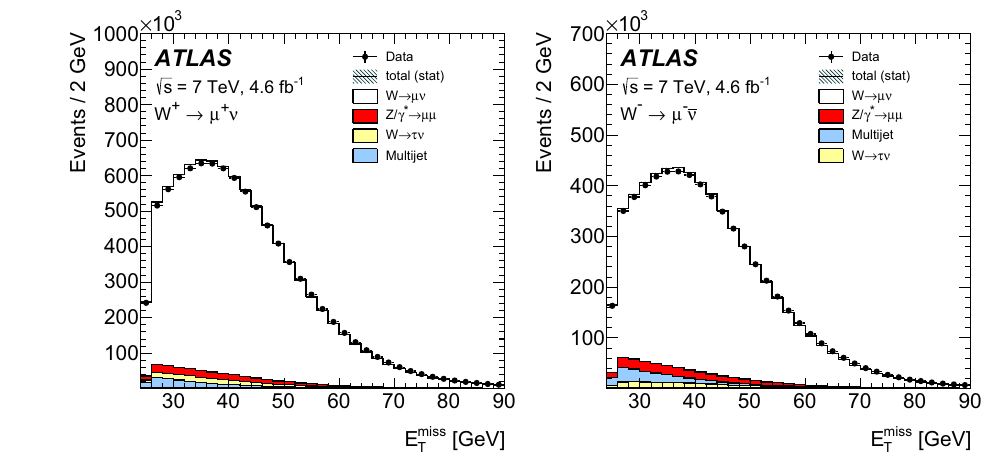
Fig. 12 The missing transverse momentum distribution for W + → μ + ν candidates ( left ) and W − → μ − ¯ ν candidates ( right ). The simu- lated samples are normalized to the data luminosity. The multijet back- ground shape is taken from a data control sample and normalized to